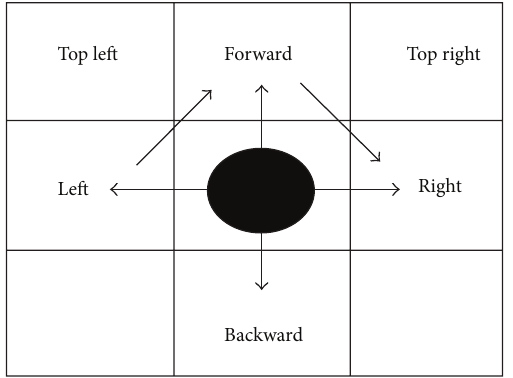
Figure 1: The motion direction of walkers.